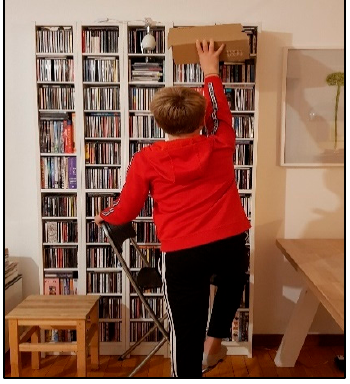
Figure 3. Picture associated with (34) .